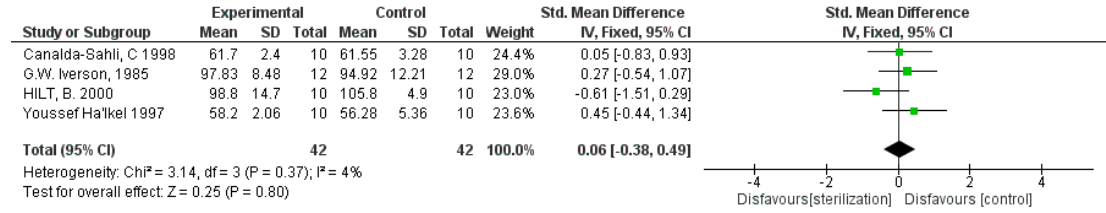
ff ects model of the meta-analysis of the tertiary Figure 3. Forest plot of the fixed effects model of the meta-analysis of the tertiary outcome. Figure 3. Forest plot of the fixed e Figure 3. Forest plot of the fixed effects model of the meta-analysis of the tertiary outcome. Figure 3. Forest plot of the fixed effects model of the meta-analysis of the tertiary outcome.